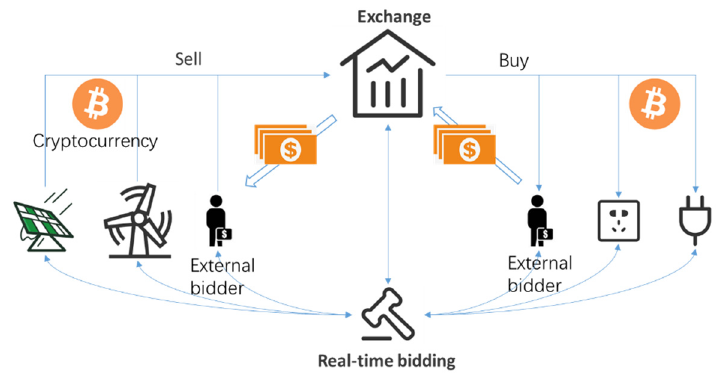
Figure 4. ECE architecture.